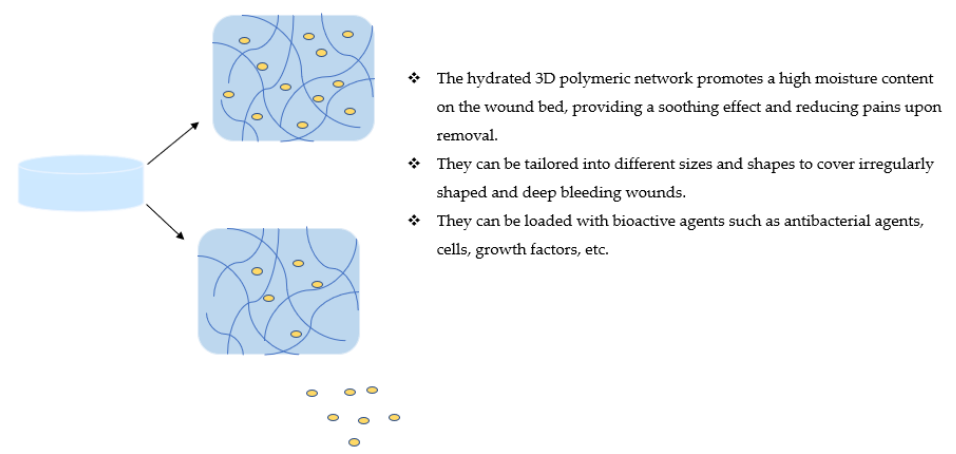
Figure 5. Hydrogels loaded with bioactive agents.